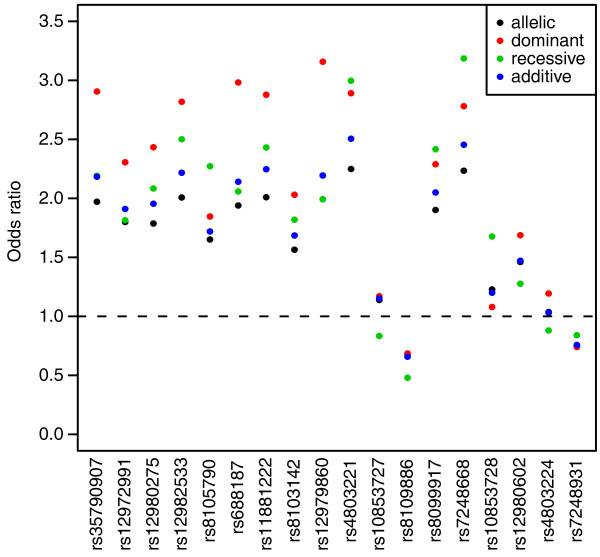
Odds ratios for the eighteen individually genotyped SNPs under four different genetic models.